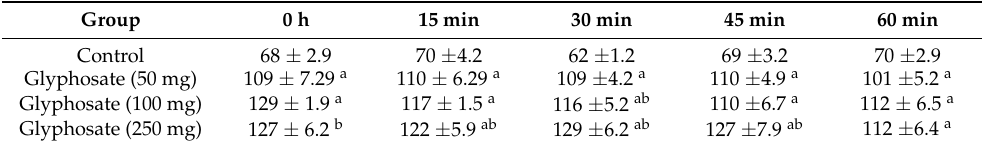
Table 3. Level insulin tolerance in glyphosate exposed animals.